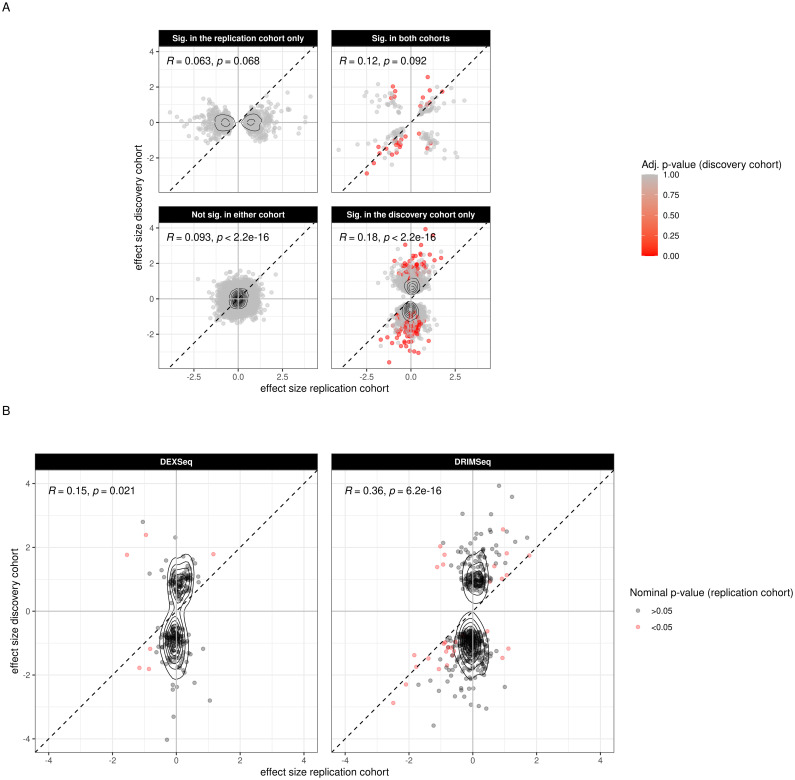
DTU replication in an independent cohort.Each data point corresponds to one transcript. The estimated effect size in the discovery cohort is represented on the y-axis and the estimated effect size for the replication cohort on the x-axis. A: The overlapping set of transcripts between the two cohorts is divided into 4 categories depending on their nominal significance in either cohort according to DRIMSeq. Transcripts not found to be significant in any cohort are shown in the lower left quadrant. Transcripts found to be significant in both cohorts in the upper right quadrant. Transcripts found to be significant only in the replication or in the discovery cohort are in the upper left and lower right quadrant respectively. The color scale (red-gray) shows adjusted p-value in the discovery cohort. B: Displayed are all DTU events (significant after correction) of the discovery cohort. Red color indicates nominal significance (before correction) in the replication cohort. The two columns present the results obtained from each respective tool.